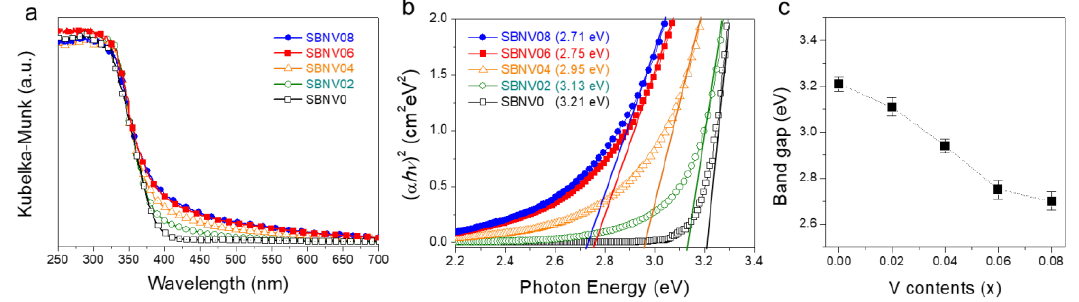
Figure 3. Optical properties. ( a ) Kubelka-Munk function. ( b ) (α hν ) 2 versus photon energy. ( c ) Bandgap values of SrBi 2 Nb 2 − x V x O 9 powders, with x = 0, 0.02, 0.04, 0.06, and 0.08 (SBNV0, SBNV02, SBNV04, SBNV06, and SBNV08, respectively).